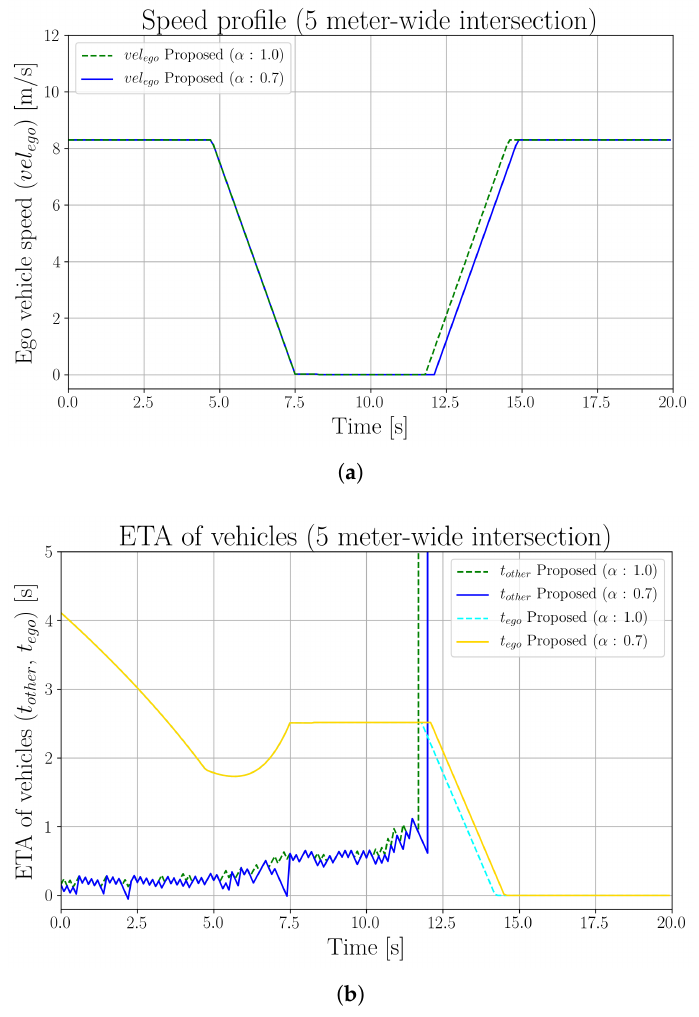
Figure 16. Effects of perception noise on the proposed planner at a 5 m wide occluded intersection. ( a ) Ego vehicle speed profiles at a 5 m wide occluded intersection. ( b ) Estimated time of arrival of vehicles at a 5 m wide occluded